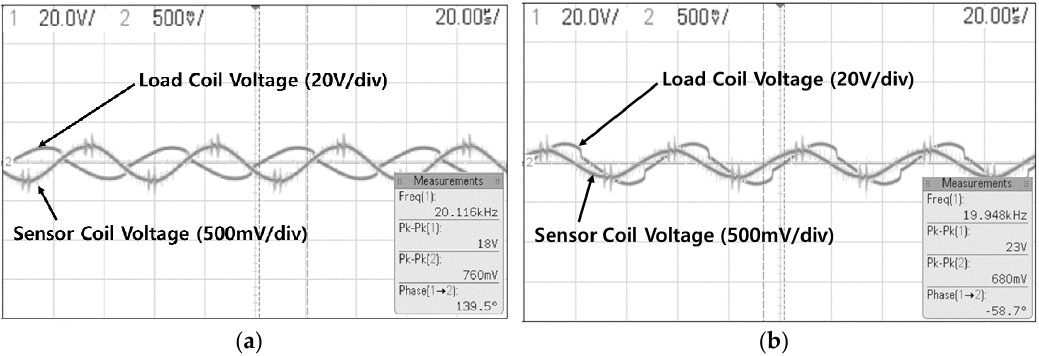
Figure 22. Oscilloscope readings from the second experiment showing the voltage waveform of the load coil and sensor coil unit at ( a ) left misalignment; and ( b ) right misalignment. The waveforms (1) and (2) shown in Figure 23 show the converted square waveforms of the load coil and sensor coil outputs from Figure 22, respectively. These converted square waveforms are fed into the XOR gate, and the output signals are shown as waveform (3) in Figure 23. Figure 23a,b represent the left misalignment case and the right misalignment case, respectively. As can be seen from Figure 21, a phase difference between the load coil and sensor coil exists, thus the output generated by the XOR gate is an “unclean” HIGH or LOW logic output. However, it still verifies the concept illustrated in Figure 14.